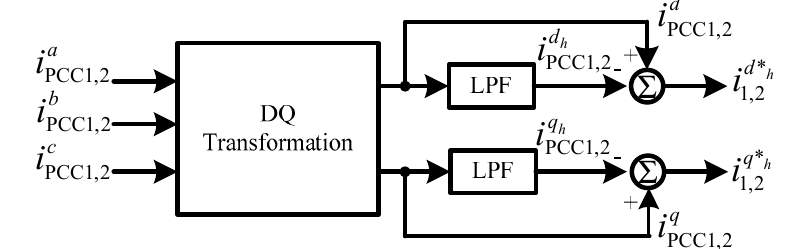
Figure 5. Block diagram to obtain the harmonic current reference waveforms.